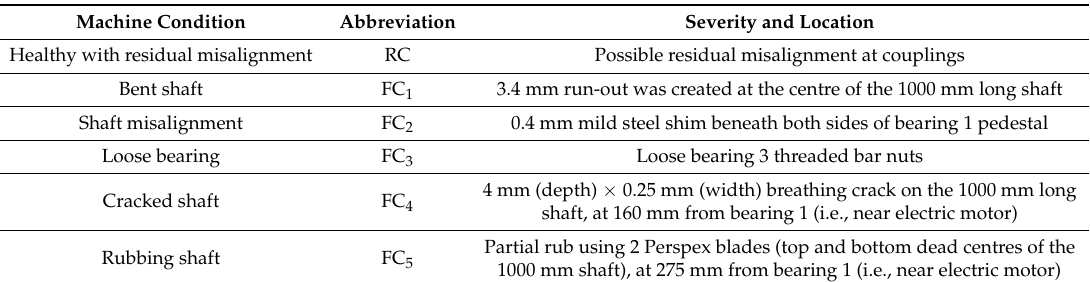
Table 1. Experimentally simulated machine conditions.